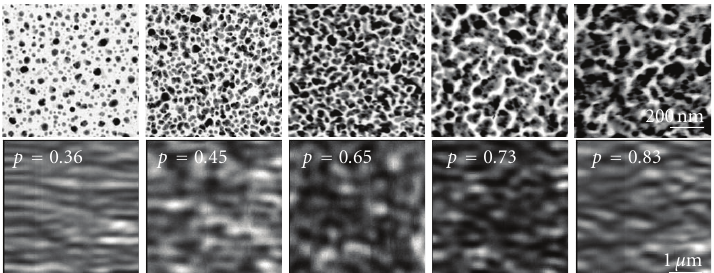
Figure 1: TEM micrographs of silver semicontinuous films on glass substrates showing the metal nanostructure geometry for various metal concentrations in the first row. The second row shows the inhomogeneous distribution of the near-field intensity for corresponding samples.